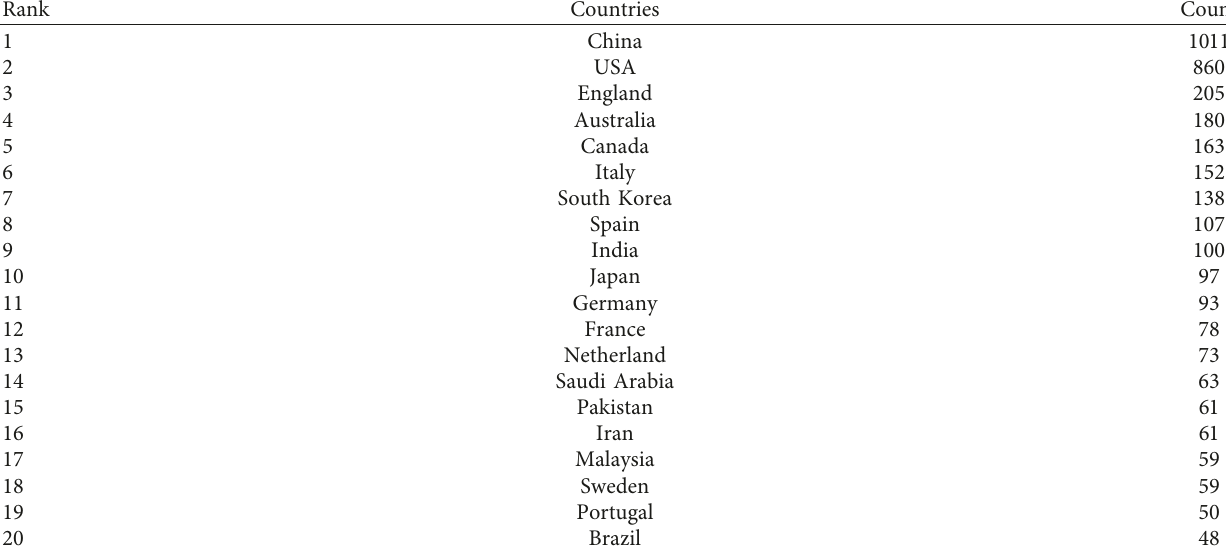
Table 2: Top 20 countries in the number of